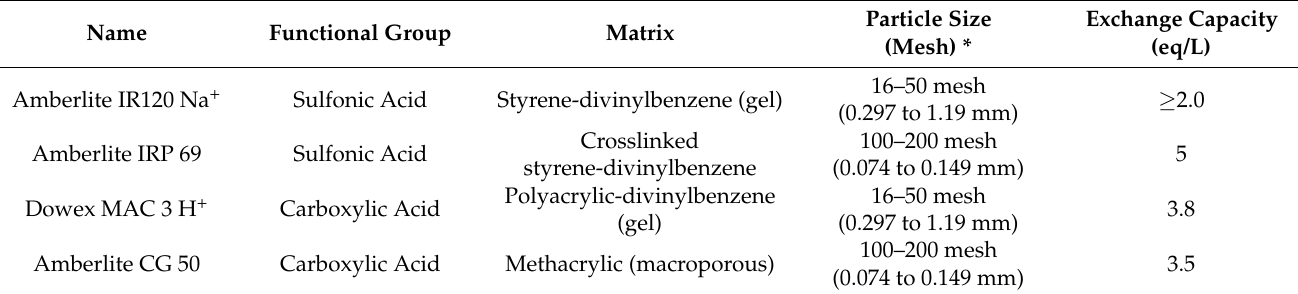
Table 1. Cation exchange resins and their